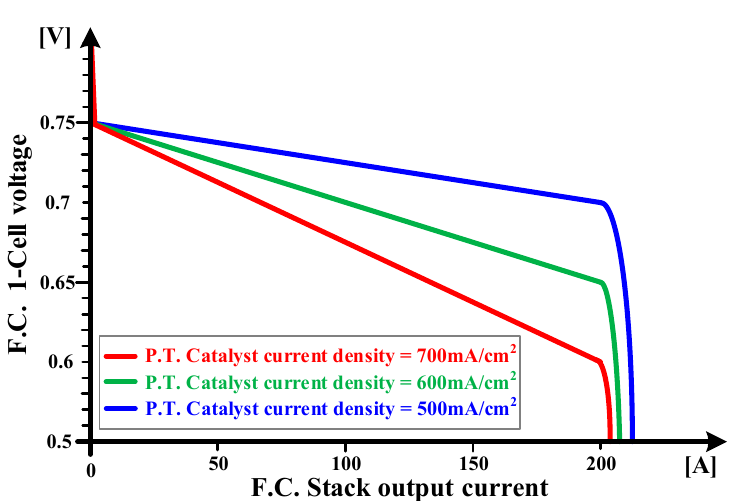
Figure 6. Voltage characteristic curve depending on the current density of platinum catalyst.